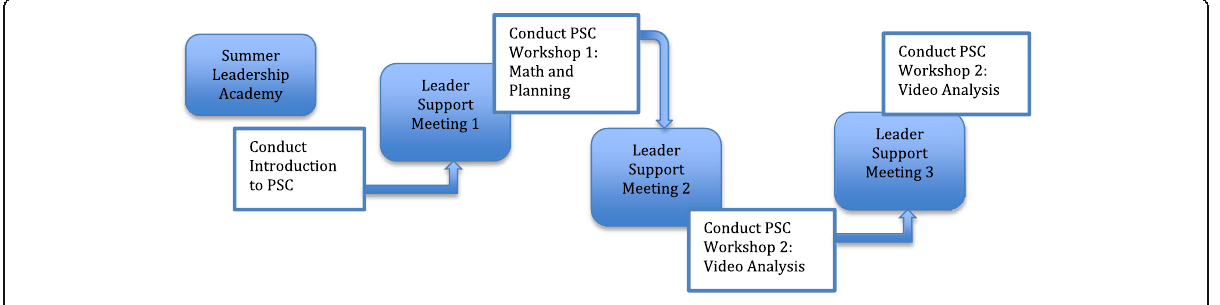
Fig. 2 The Mathematics Leadership Preparation